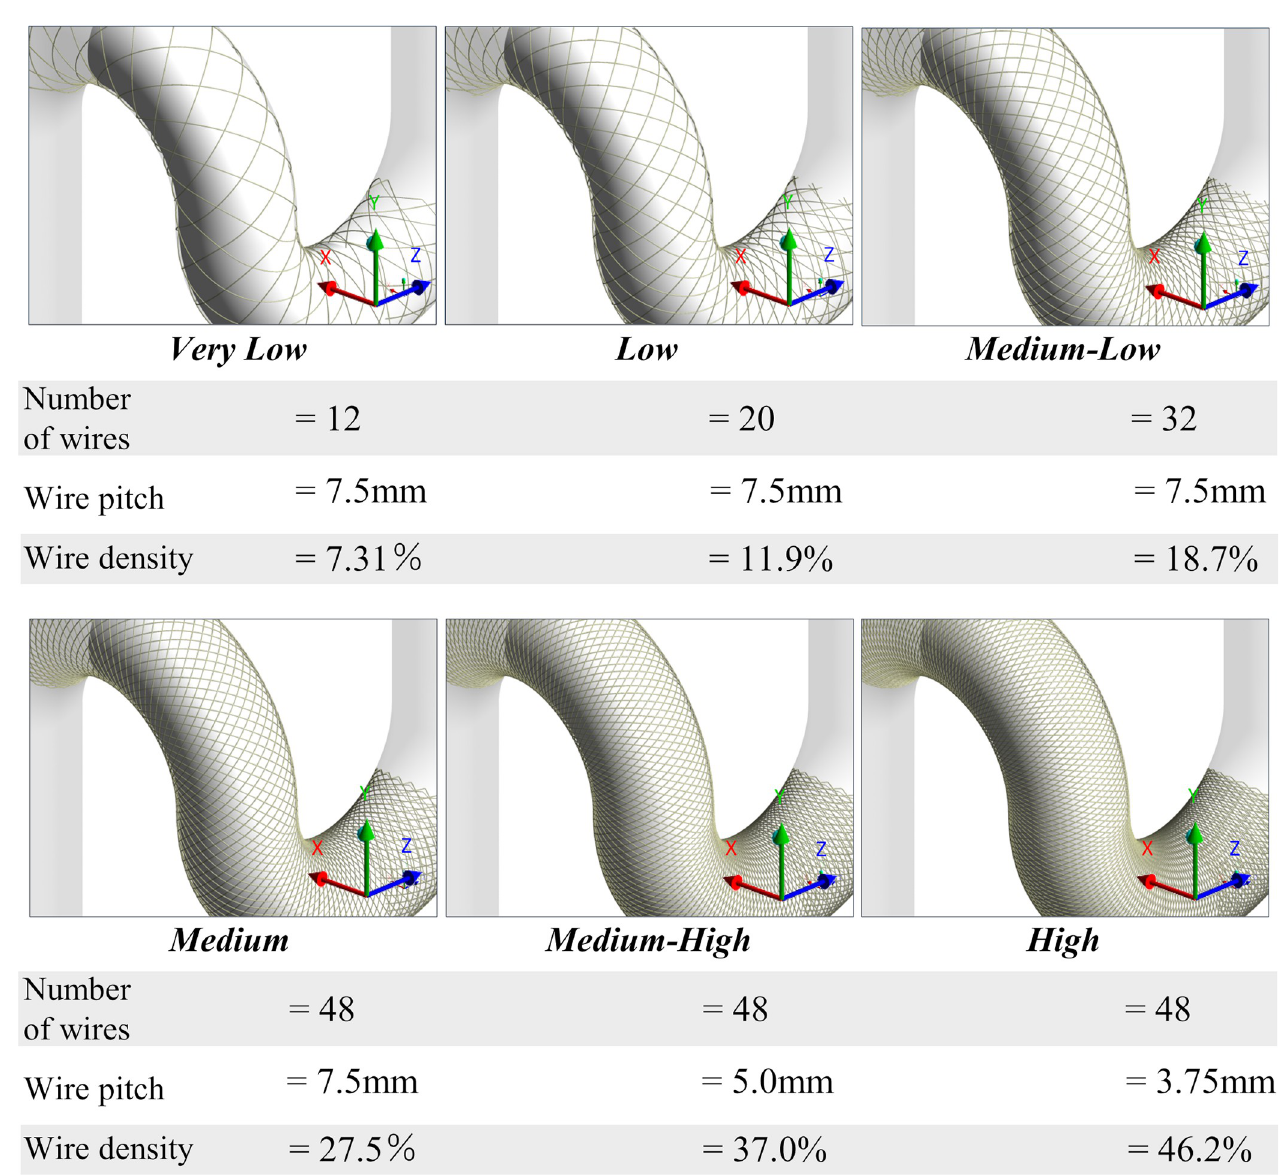
Fig 2. Generated 6 types of deployed stents. The Stents were generated by varying the number of wires and wire pitch, and the wire density was calculated.